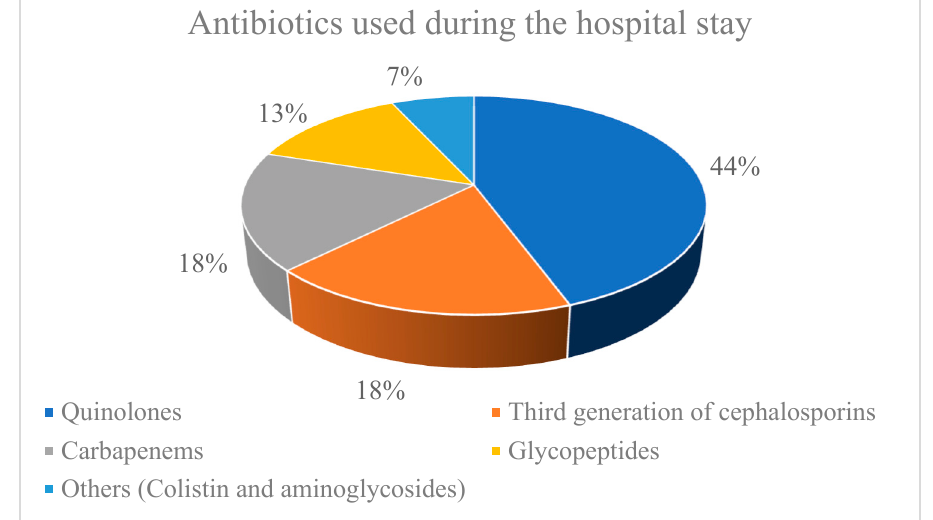
Figure 3. Antibiotics used during patient hospital stays.